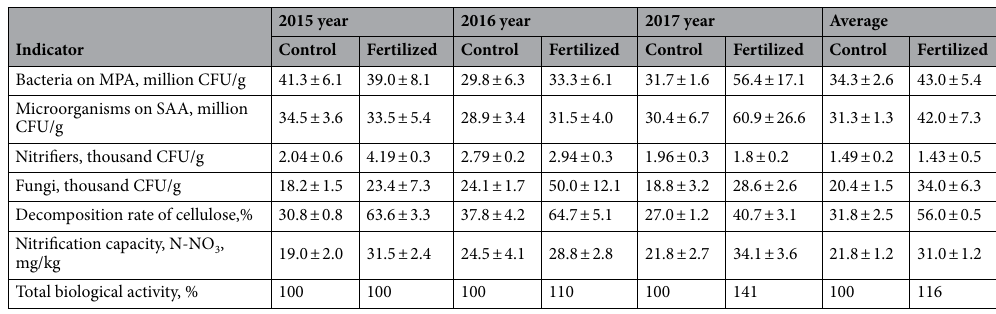
Table 2. Biological activity of irrigated meadow-chernozem soil under barley, depending on fertilization.